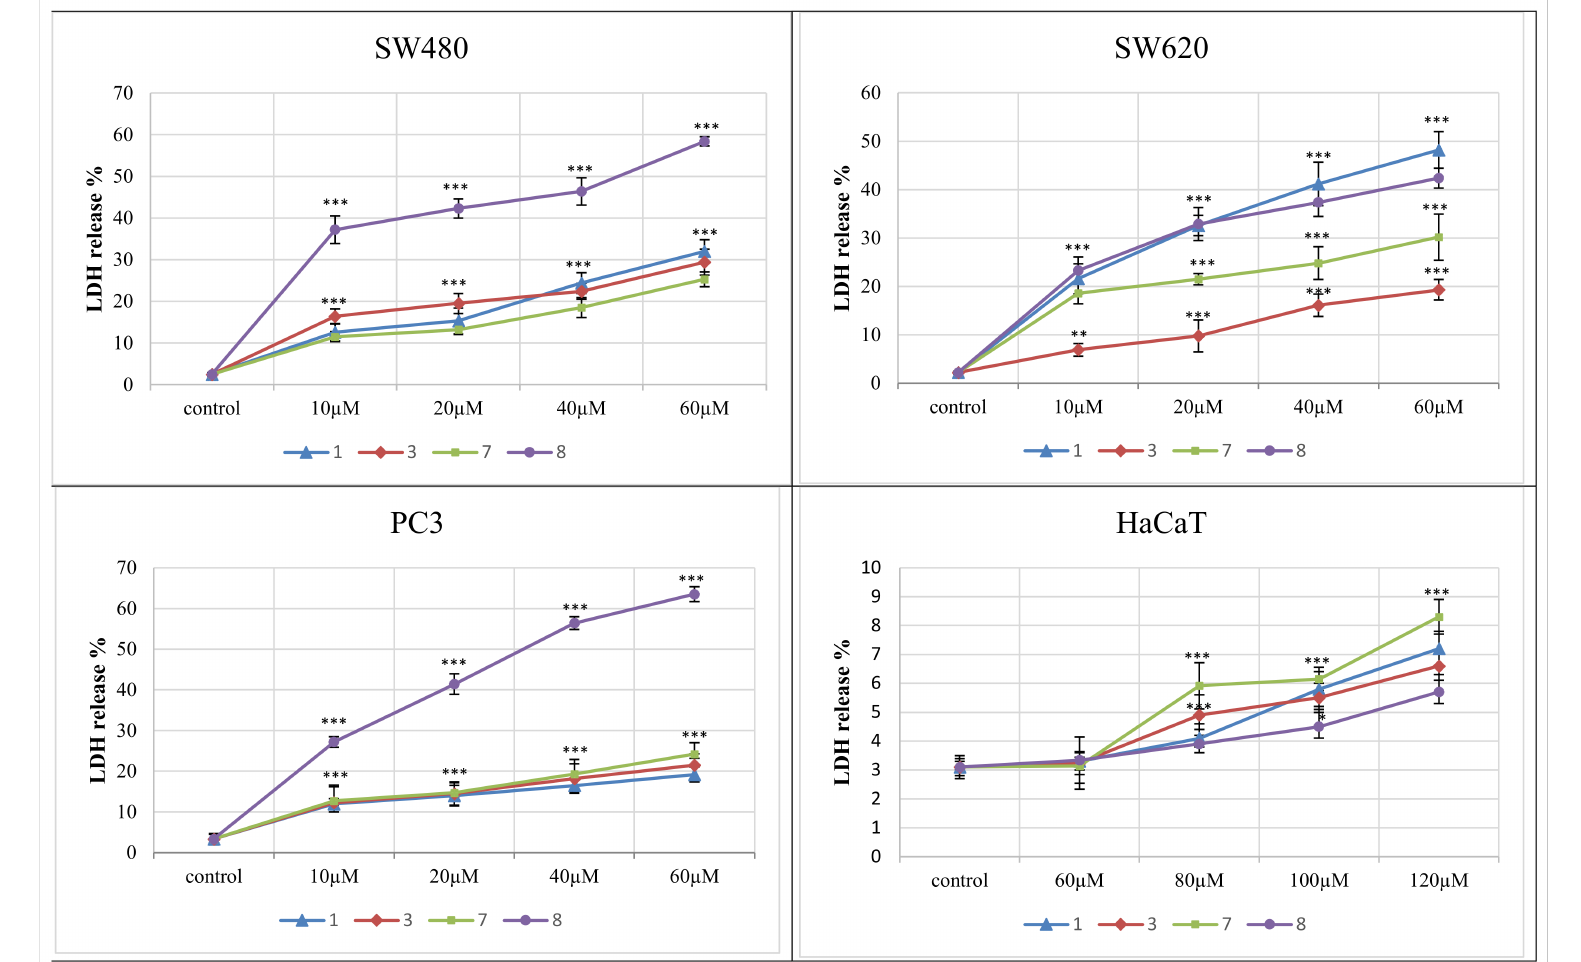
Figure 5. Lactate dehydrogenase (LDH) release as a marker of cell death in the SW480, SW620, PC3 and HaCaT cells, treated for 72 h with different concentrations of compounds 1 , 3 , 7 and 8 . LDH release in the HaCaT was analyzed after treatment with higher doses of compounds. *** p ≤ 0.001 as compared to the